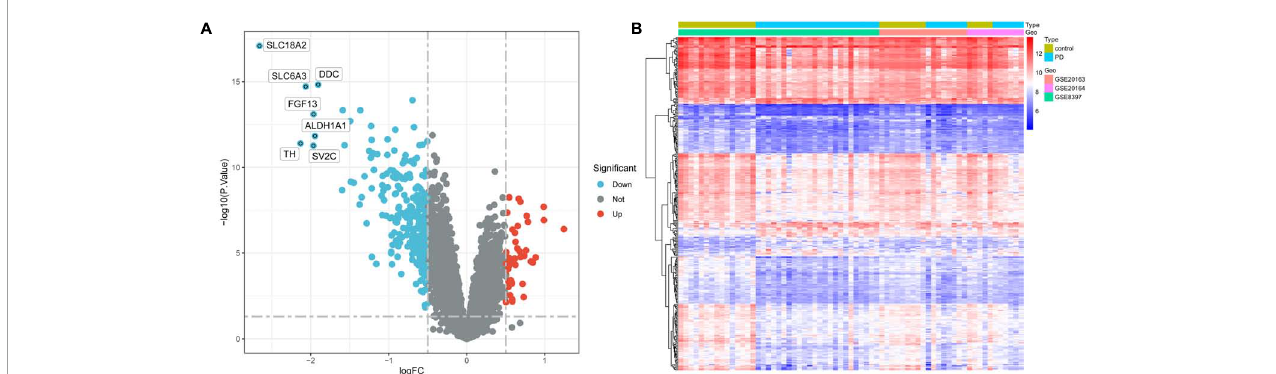
FIGURE2 Identification of DEGs in the integrated dataset. (A) Volcano plot of all DEGs. The tomato nodes represent upregulated DEGs with p -value < 0.05 and logFC > 0.5; the cyan nodes represent downregulated DEGs with p -value < 0.05 and logFC < –0.5. (B) Heatmap of DEGs in PD samples vs. normal samples. Each row of the heatmap represents one gene, and each column represents one sample. The red and blue colors represent gene expression levels corresponding to upregulated and downregulated expression. DEGs, differentially expressed genes; FC, fold change; PD, Parkinson’s